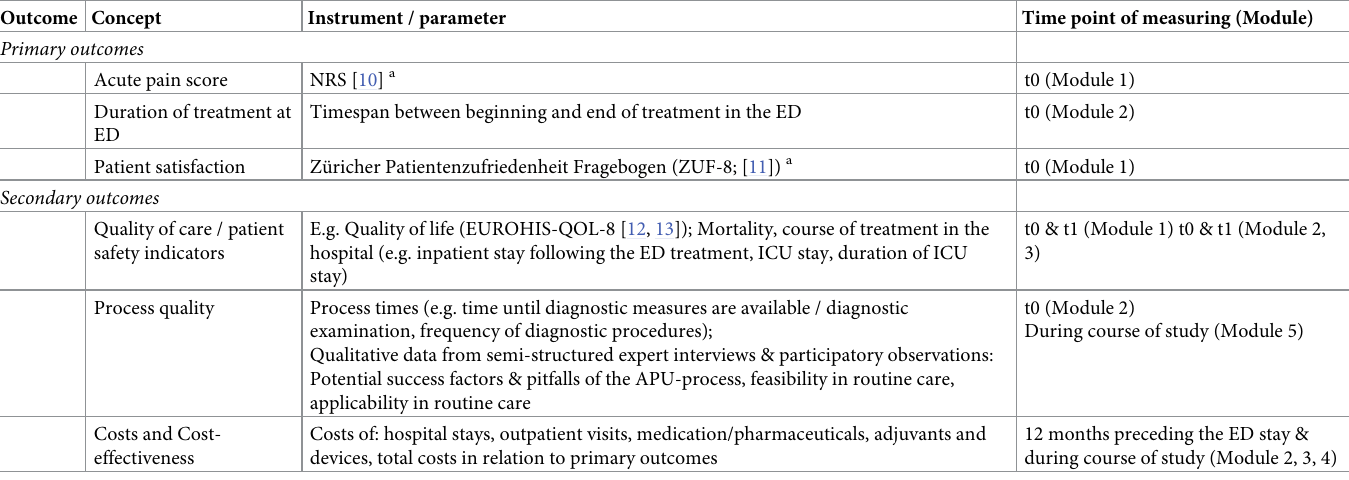
Table 1. Overview of primary & secondary